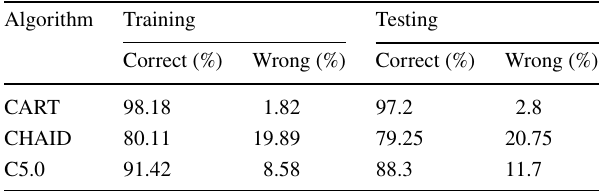
Table 8 Evaluation of the results of tree algorithms in predicting clusters related to quantitative traits of guar